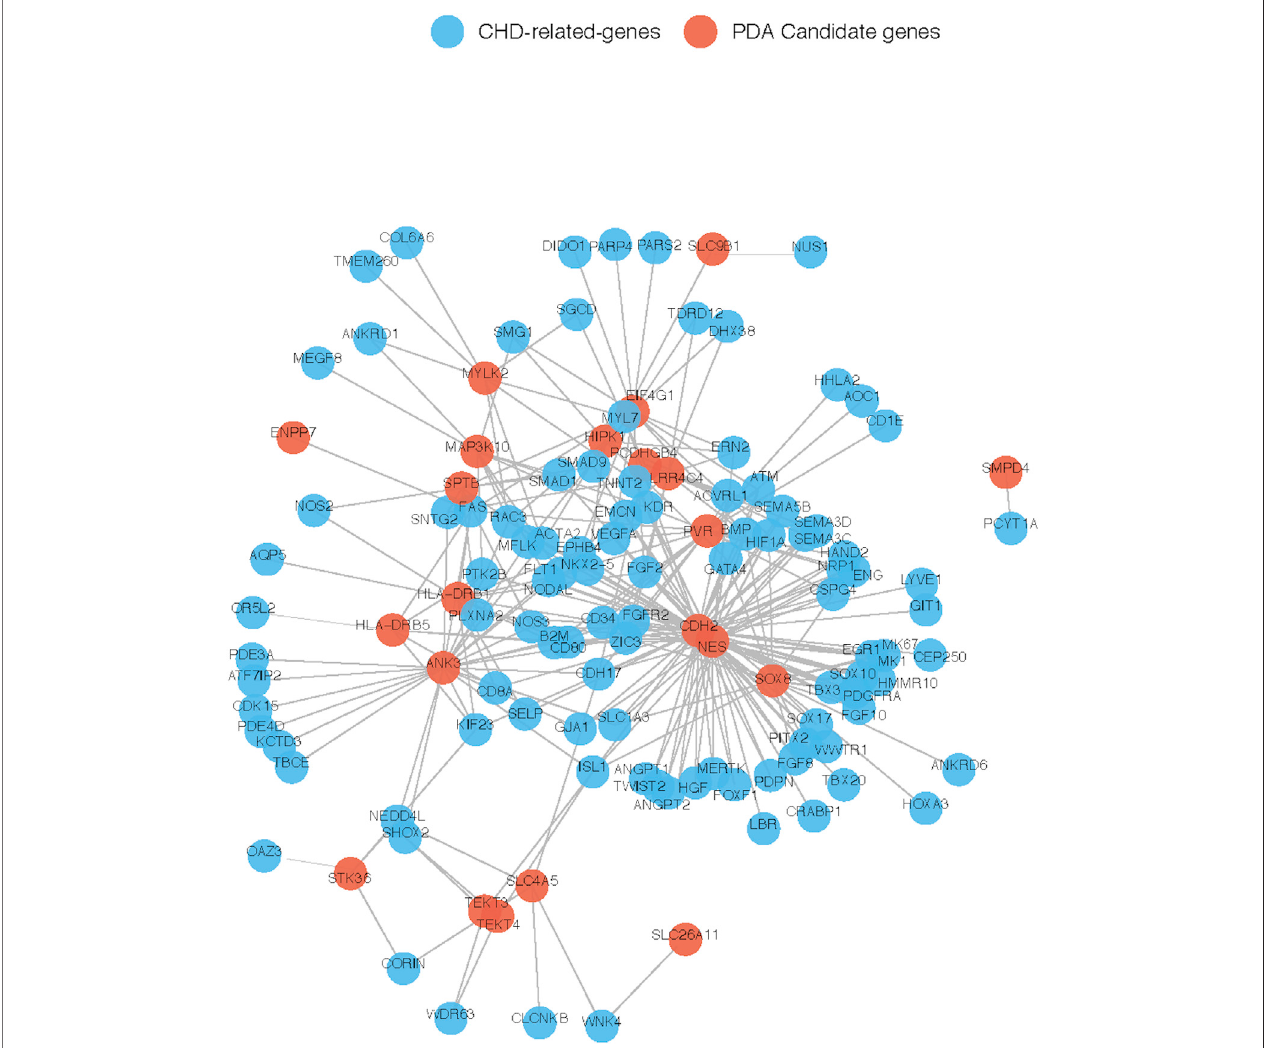
FIGURE 7 | Interaction between our candidate genes and known CHD-related genes. PPI network was generated by Cytoscape software and our candidate pathogenic genes and the known CHD-related genes were uploaded in STRING database. Each node represents one gene, and each edge represents the protein- protein interaction collected from